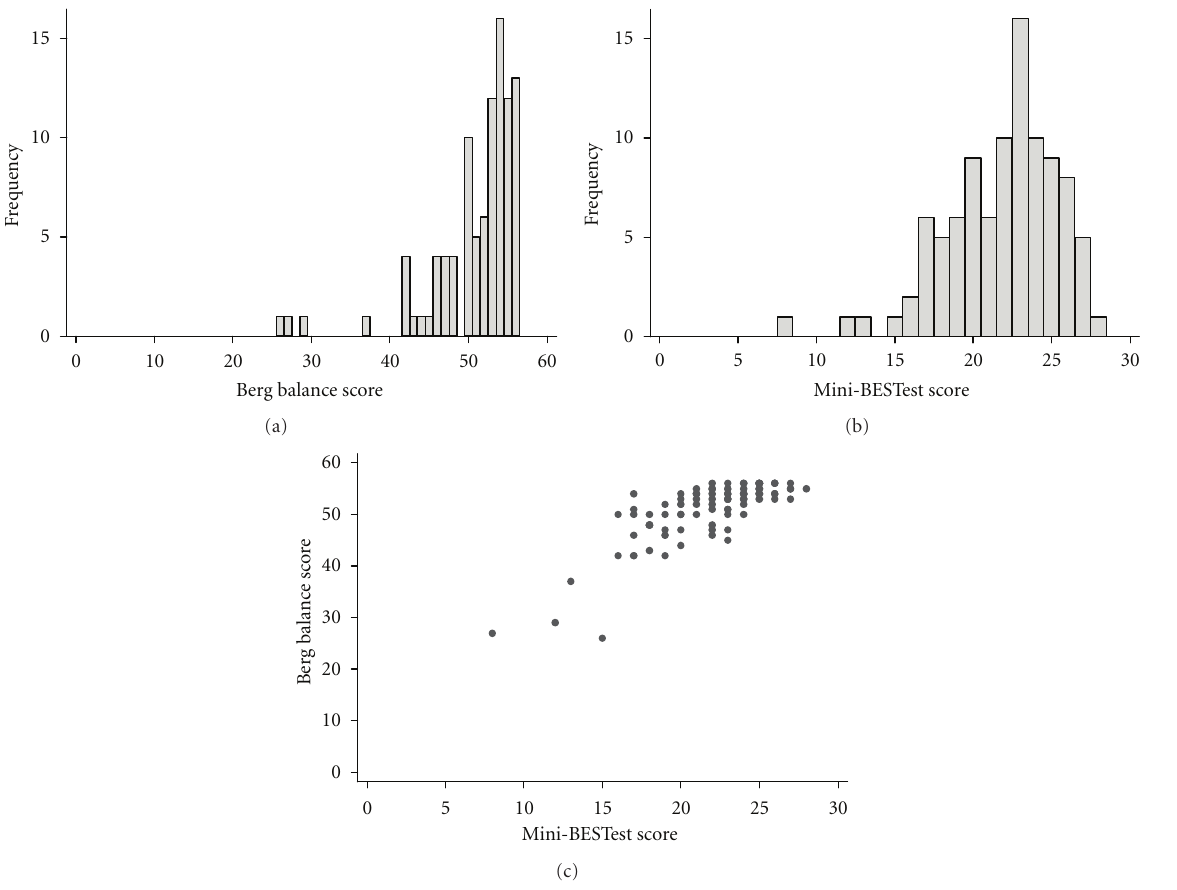
Figure 1: Distribution of scores for the Berg Balance scale (a) and Mini-BESTest test (b), along with a scatter plot showing their relationship to one another (c) for 97 patients with Parkinson’s